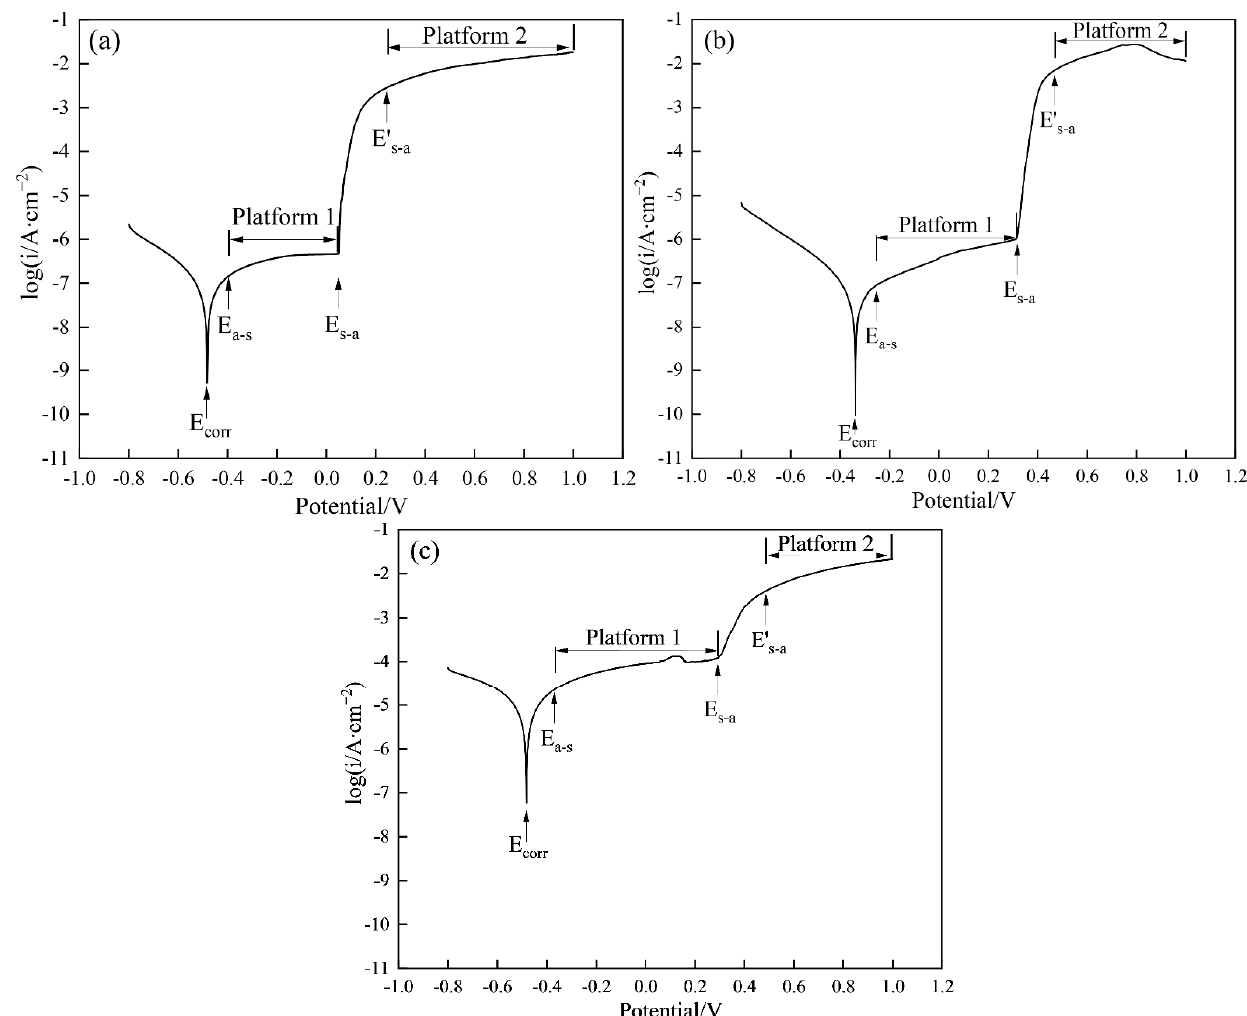
Figure 11. Potentiodynamic polarization curves of the Coatings in the 3.5 wt.% NaCl solution (( a ) Coating 1 for 5 mm ∙ s − 1 ;